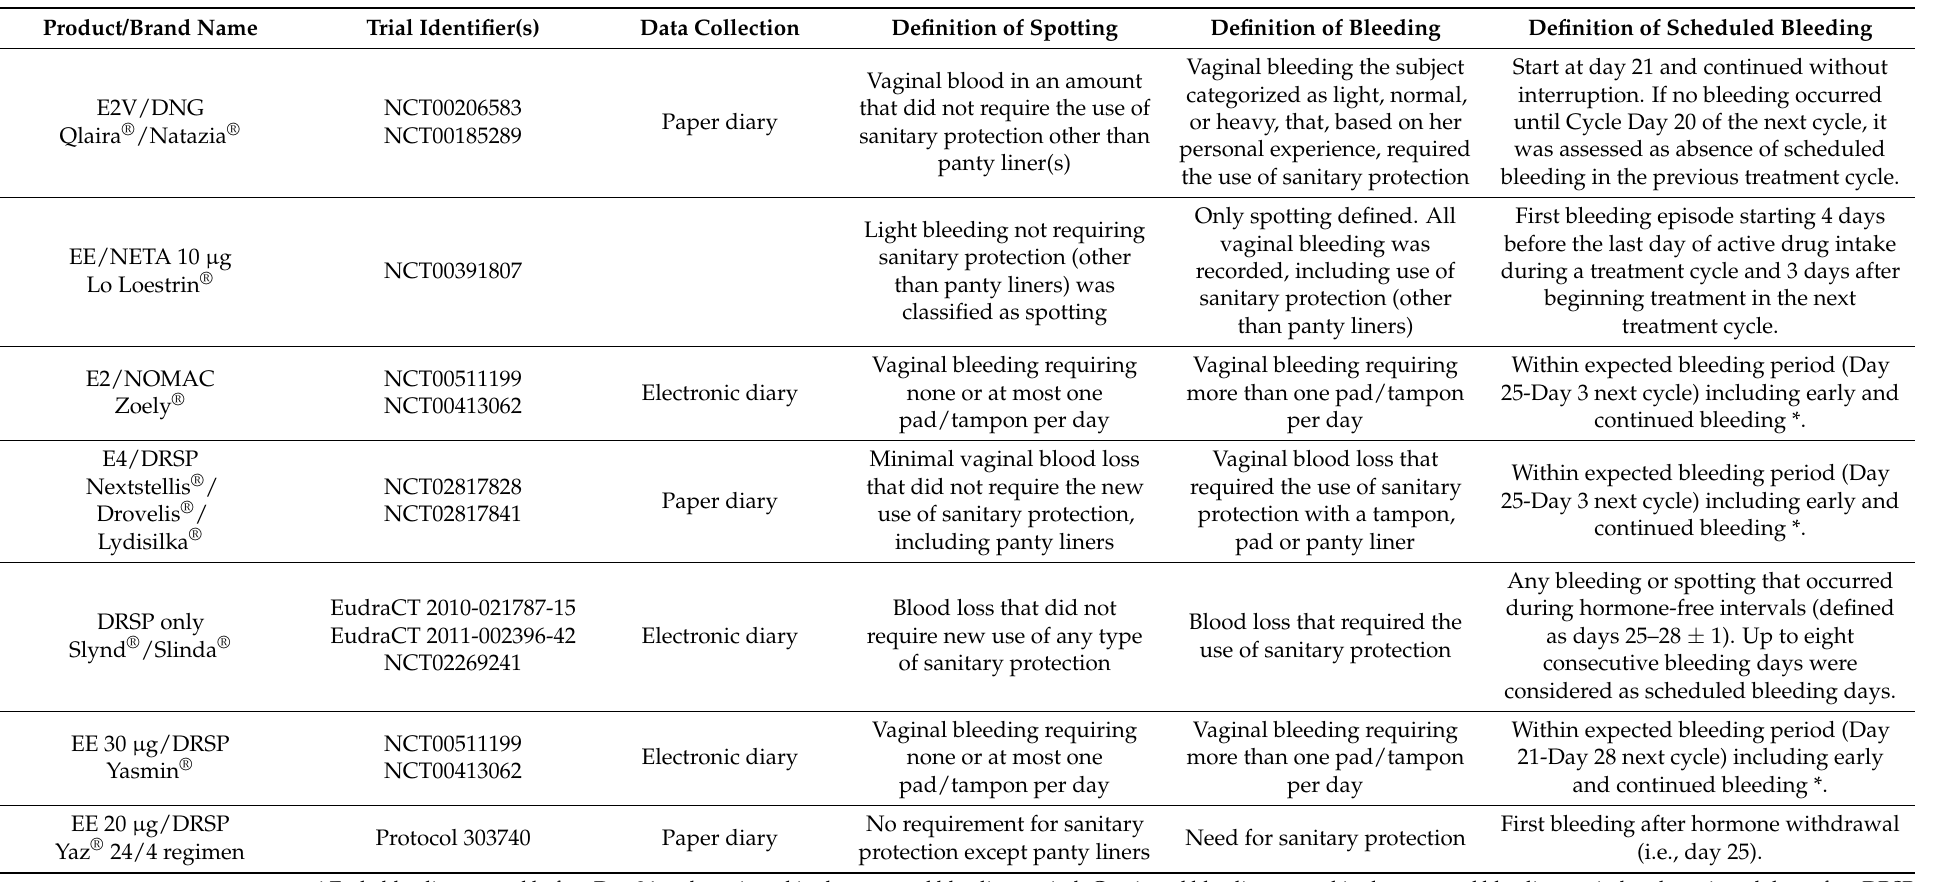
Table 3. Heterogeneity of bleeding/spotting data collection and definition in the phase 3 trials of the different OCs